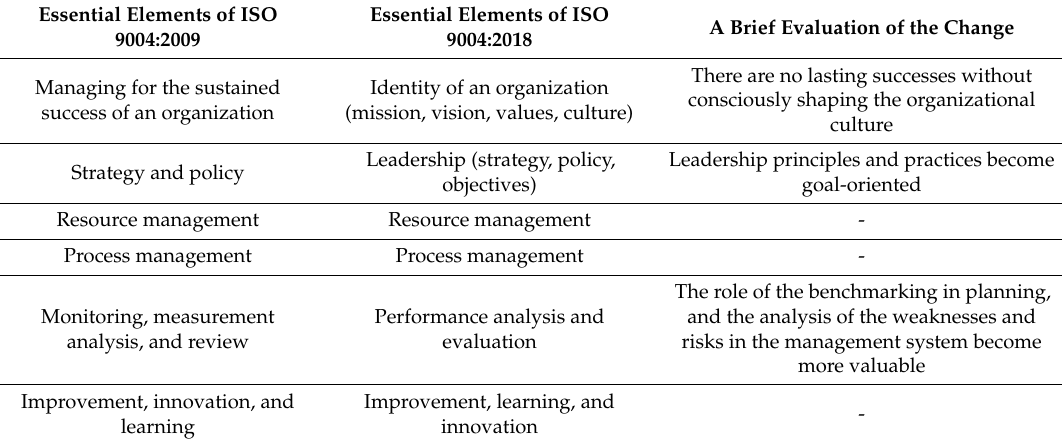
Table 2. Essential elements of the structure of ISO 9004:2009 [23] and ISO 9004:2018 [17]. Essential Elements of ISO